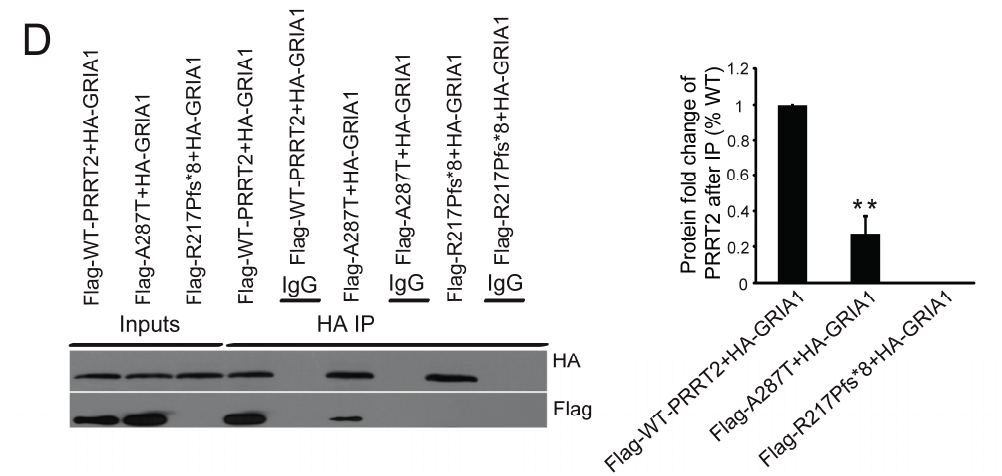
Figure 4. Mutant PRRT2 interfered interactions between PRRT2 and its partners. ( A ) In vitro co-immunoprecipitation using cell extracts from HEK293T cells co-transfected with Myc-tagged SNAP25 and Flag-tagged different forms of PRRT2. After pull-down with Flag antibody, western blotting results demonstrated interactions between SNAP25 and different forms of PRRT2. Histogram showed the fold change of SNAP25 protein level after co-immunoprecipitation with Flag antibody; ( B ) In vitro co-immunoprecipitation with cell extracts from HEK293T cells co-transfected with Myc-tagged Prrt2 and HA-tagged Gria1. After pull-down with HA antibody, western blotting results showed interactions between Prrt2 and Gria1; ( C ) In vitro immunoprecipitation of Prrt2 and Gria1 in mouse brain extract using anti-Gria1 antibody. Western blotting was used to visualize protein signals; ( D ) In vitro co-immunoprecipitation using cell extract from HEK293T cells co-transfected with HA-tagged GRIA1 and Flag-tagged different forms of PRRT2. After pull-down with HA antibody, western blotting results showed interactions between GRIA1 and different forms of PRRT2. Histogram shows the fold change of PRRT2 protein levels after co-immunoprecipitation with HA antibody. Values are represented as mean ± SD, n = 3, ** p <